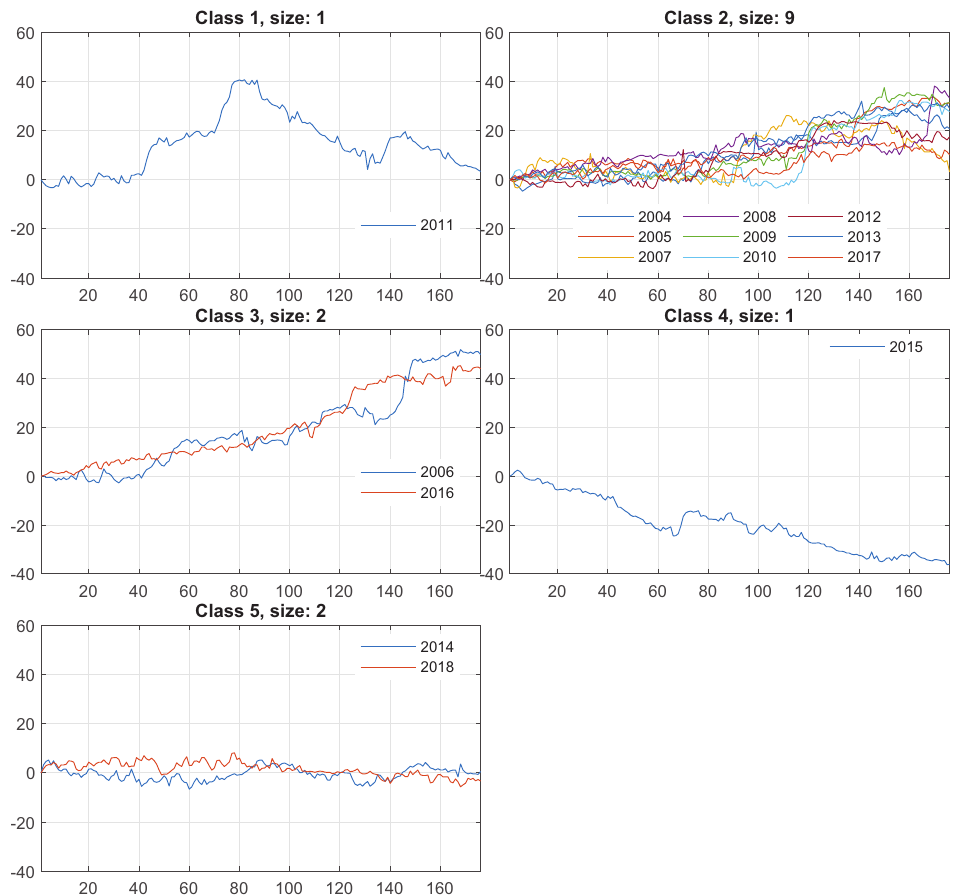
Figure 14. Clustering of the time series of detrended groundwater levels corresponding to the winter seasons by applying the AHP method. The years in the legend are corresponding to the years in the dendrogram (Figure